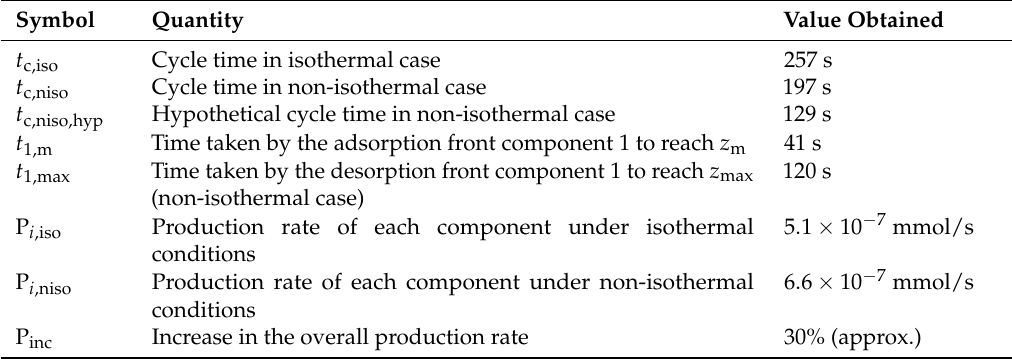
Table 3. Results for Section 4.2 (Consecutive injections of multicomponent